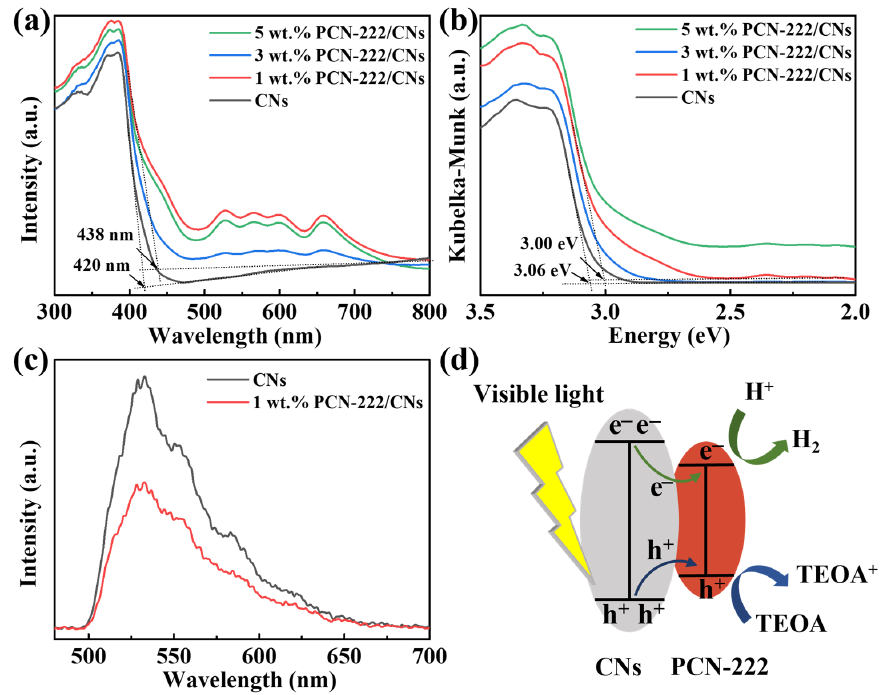
Figure 4. ( a ) UV–Vis spectra and ( b ) the corresponding ( α h ν ) 1/2 curves of CNs and PCN-222/CNs. ( c ) PL spectra of CNs and 1 wt.% PCN-222/CNs with a 325 nm excitation wavelength. ( d ) Proposed photocatalytic hydrogen evolution reaction mechanism of PCN-222/CNs vdWHs.